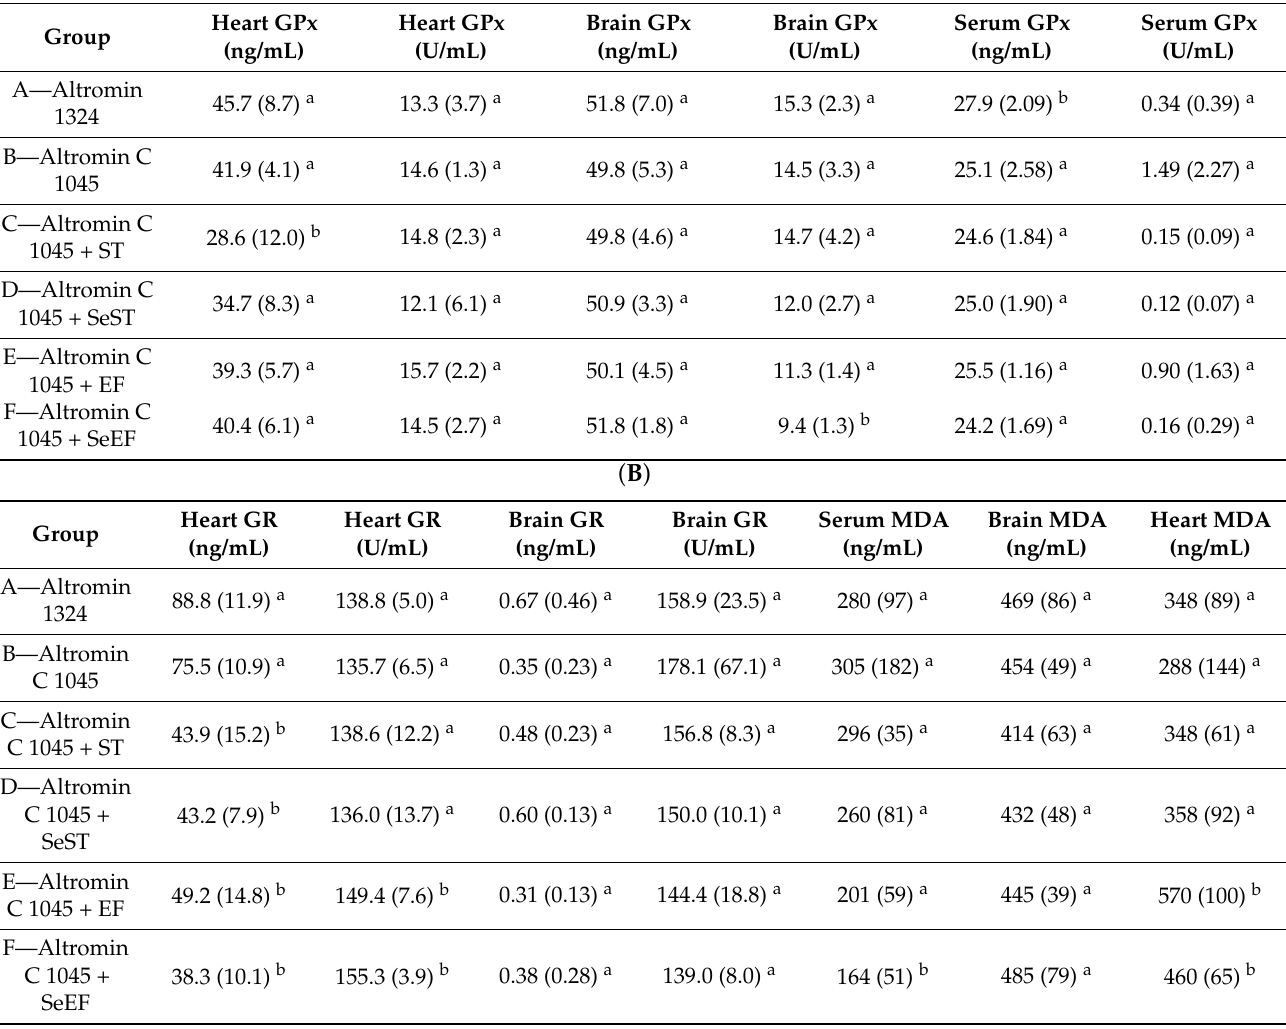
Table 5. The levels of the selected parameters of oxidative stress in the serum and tissues ( n = 8). Data are presented as the mean (standard deviation). a,b –values in columns with different superscript letters significantly differ ( p <